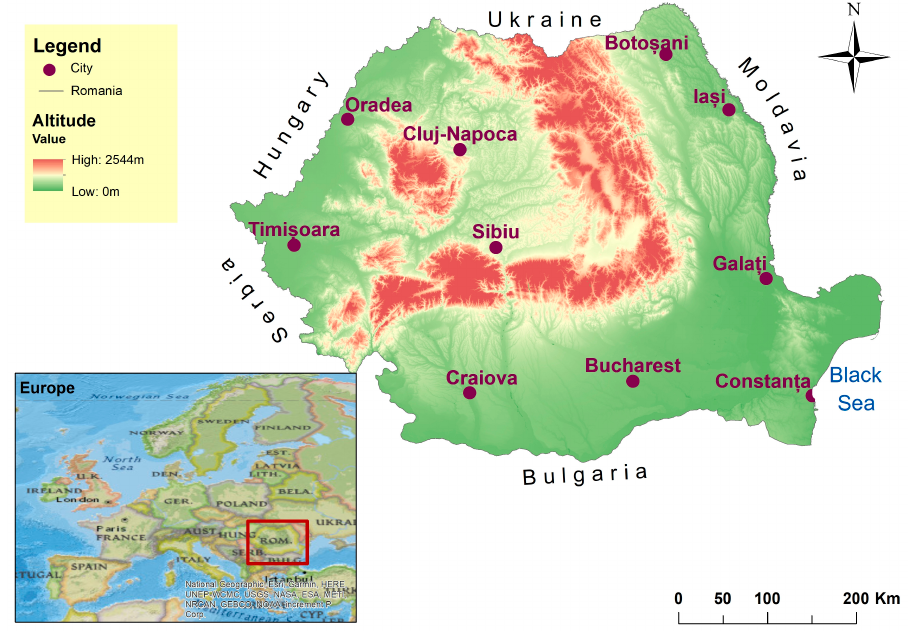
Figure 1. Topography and the weather stations considered.